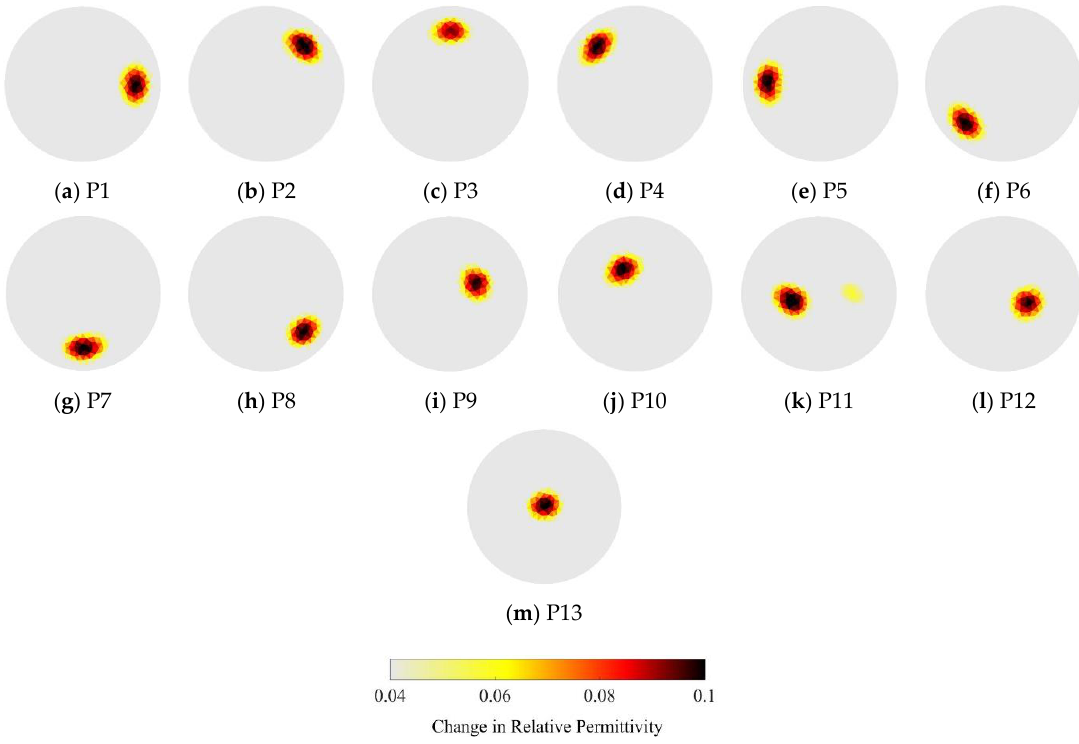
Figure 3. The ECT images were determined when the PVC rod was placed at ( a ) P1, ( b ) P2, . . . , to ( m ) P13.